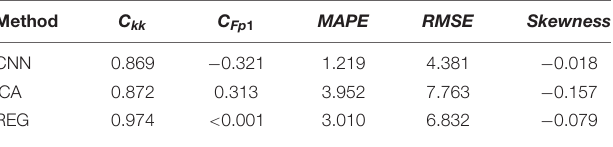
TABLE 4 | The averaged values of C kk , C Fp 1 , MAPE , RMSE, and Skewness for the P3 electrode.